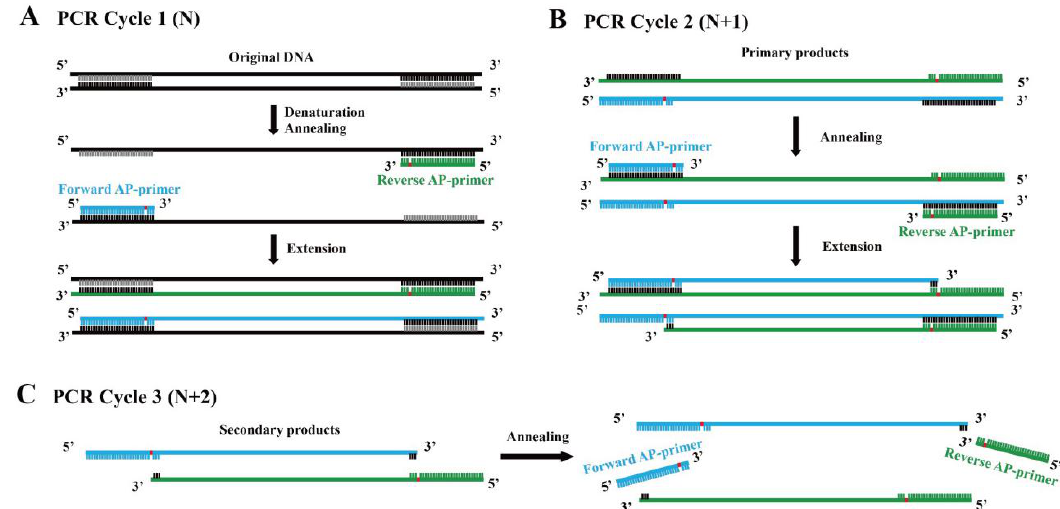
Figure 1. Replication mechanism of the abLAFD method. The location of the abasic site in primers is marked in red. ( A ): In PCR cycle 1 (N), the abasic site is introduced into the primary products. ( B ): In PCR cycle 2 (N + 1), the abasic site in the primary products acts as a blocker for the subsequent dNTP incorporation to the secondary nascent DNA strand, which results in the absence of a primer binding site in the secondary products. ( C ): In PCR cycle 3 (N + 2), abasic site-containing primers